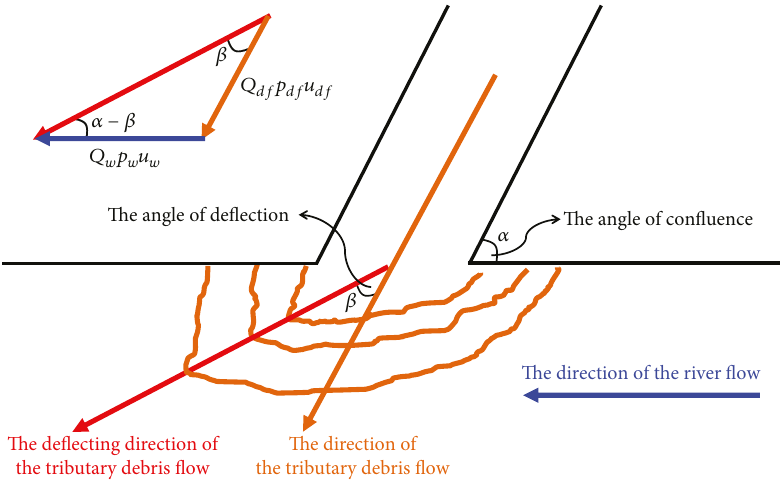
Figure 4: The resultant force direction of the river fl ow momentum and tributary debris fl ow momentum when the tributary debris fl ow enters the main